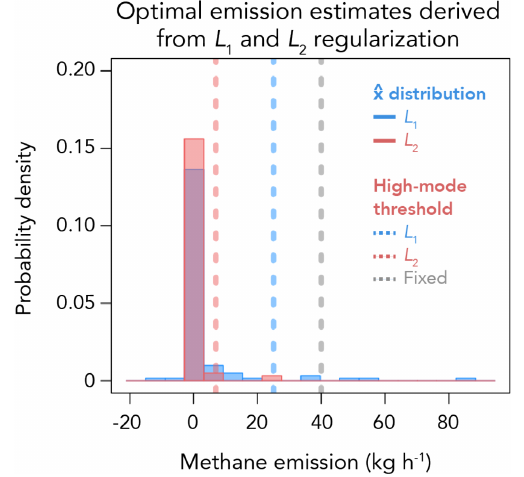
Figure 5. An example distribution of the optimal emission esti- mate ˆ x for a realization of the emission inventory (100 sites), Geo- CARB 4 × day − 1 pseudo-observations, and L 1 or L 2 regulariza- tion. Dashed lines represent the thresholds to classify an emitter as high-mode, determined either from the distribution ˆ x ( S = 2) or from a fixed prior value (here 40kgh − 1